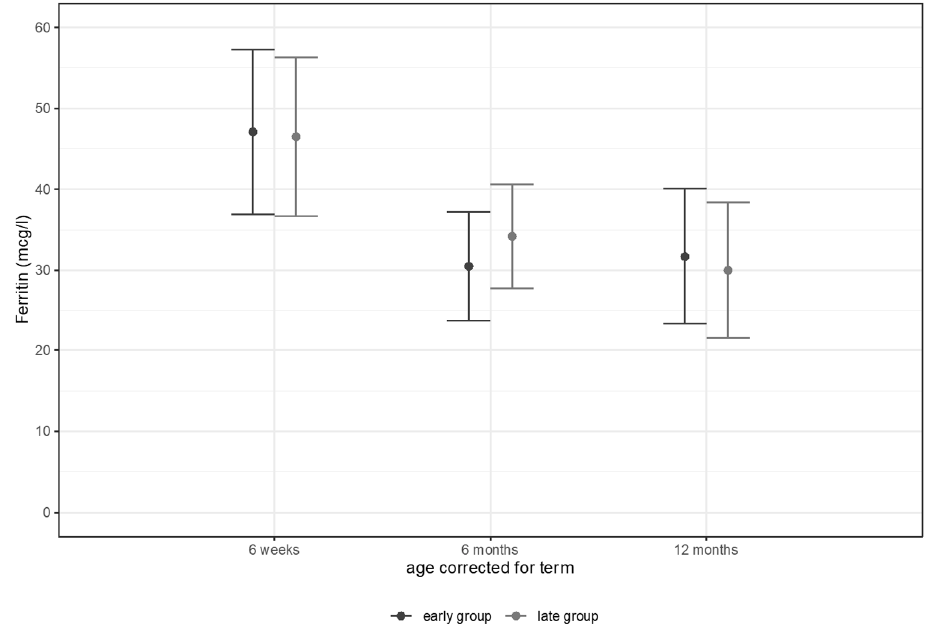
Figure 1. Ferritin levels (mcg/L) at 6 weeks, 6 months, and 12 months corrected